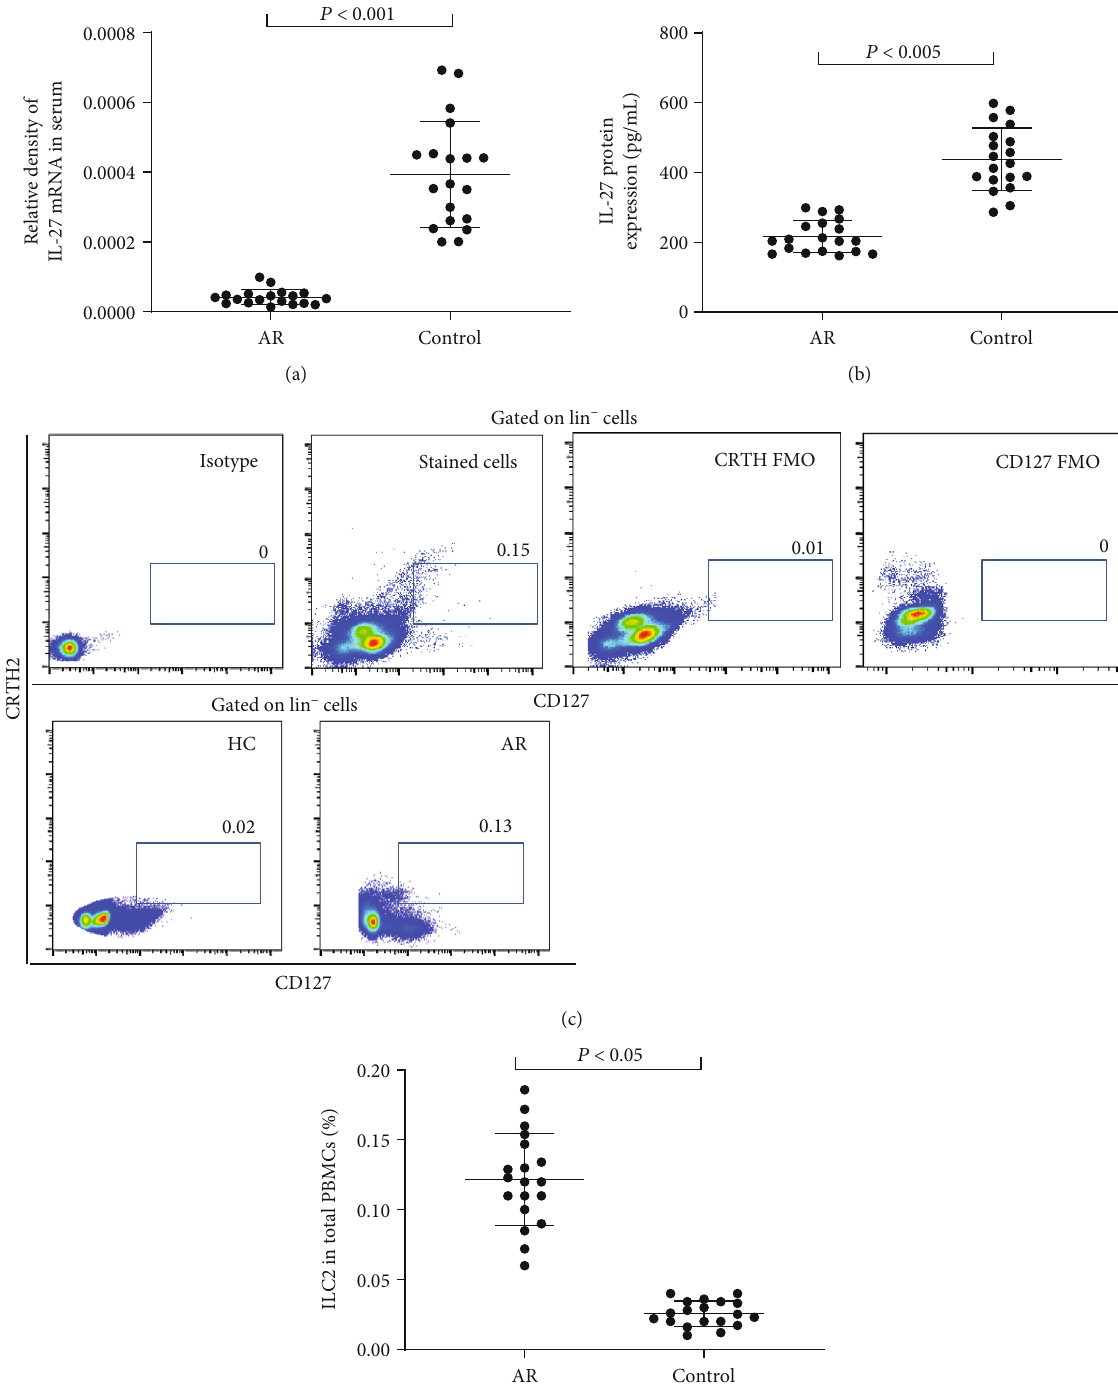
Figure 1: The serum expression of IL-27 and the proportion of ILC2 in PBMCs between AR and controls. (a, b) Expression of serum IL-27 mRNA and protein levels between AR and controls by polymerase chain reaction and enzyme-linked immunosorbent assay, respectively. (c) Frequency of ILC2 in PBMCs between controls and AR as well as isotype and FMO controls by fl ow cytometry. AR: allergic rhinitis; FMO: fl uorescence minus one; HC: healthy control; ILC2: group II innate lymphoid cells; PBMC: peripheral blood mononuclear